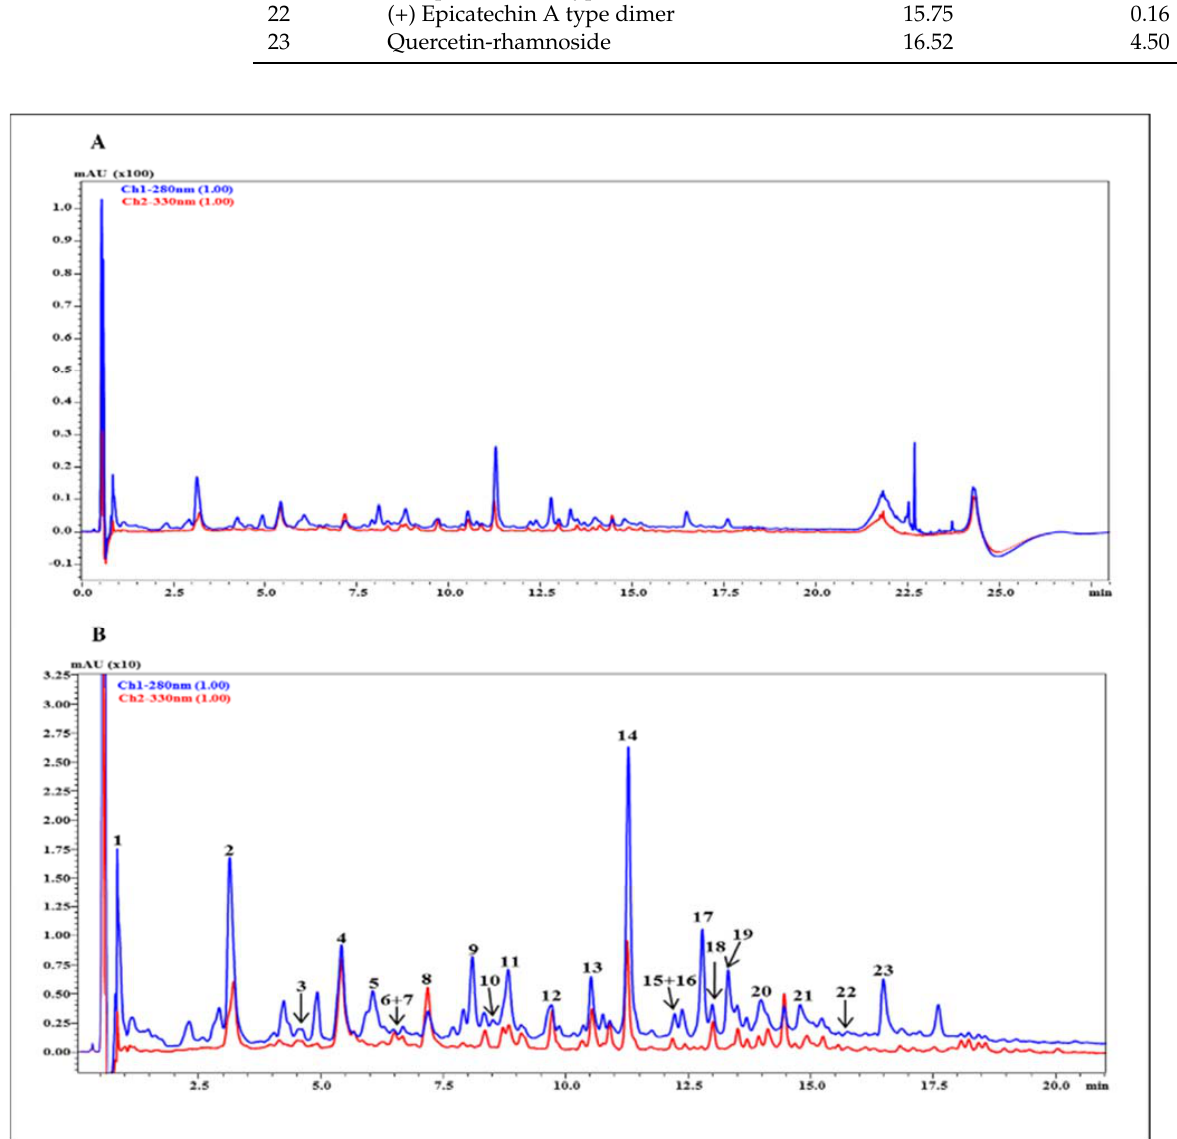
Figure 2. RP-UHPLC chromatograms of P. domestica subsp. syriaca fruit pulp extract with UV detection registered at λ 280 nm and 330 nm ( A ), and chromatogram expansion with corresponding peak HRMS assignment ( B ). Table 4. Retention time (min) and peak area, expressed as percentage of total area of the identified compounds in P. domestica subsp. syriaca fruit pulp extract.